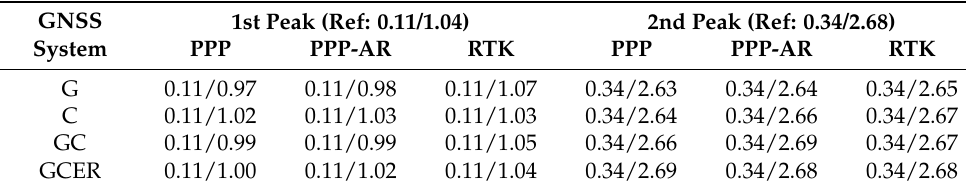
Figure 11. Amplitude–frequency spectra of displacement results from sinusoidal motion test. From top to bottom, results correspond to PPP, PPP-AR, and RTK techniques, while from left to right, results correspond to G, C, GC, and GCER observations (starting from 08:32:00 GPST). Table 2. Peak frequencies and displacement amplitudes of the different data processing techniques. (in Hz and cm,